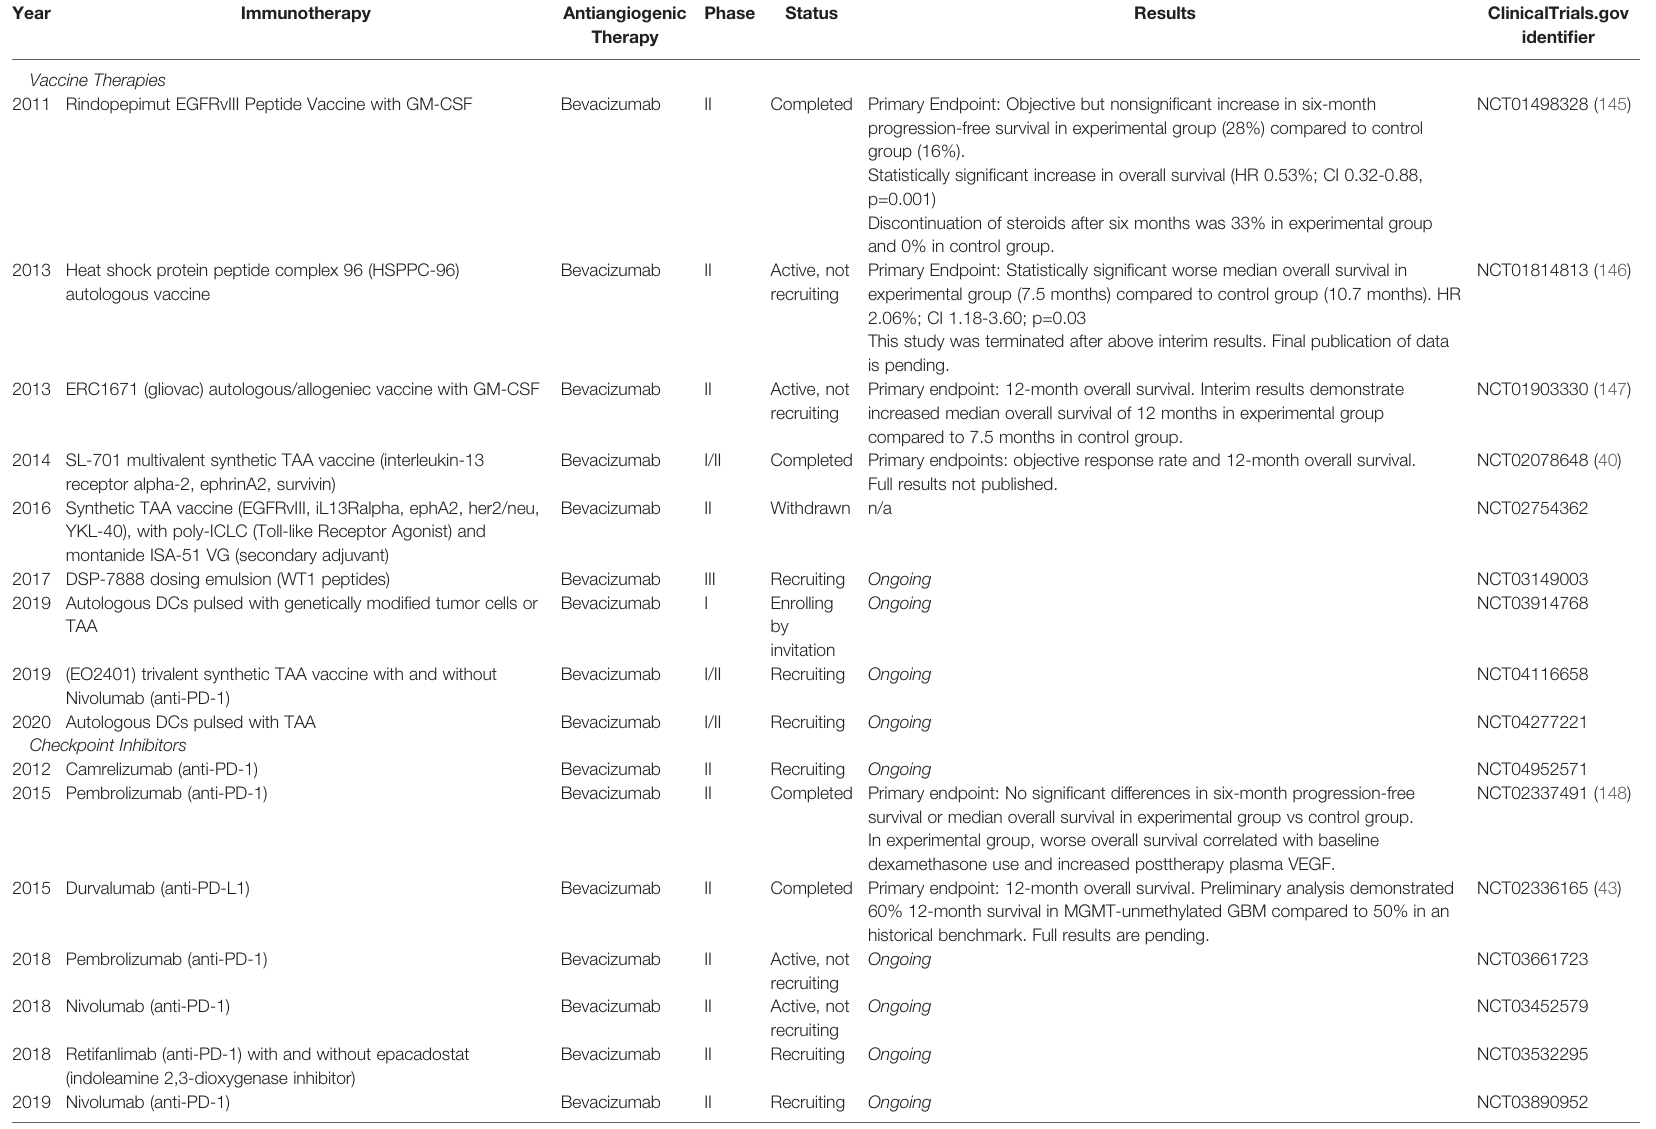
TABLE 1 | Clinical trials for glioblastoma with combination immunotherapy and anti-angiogenic